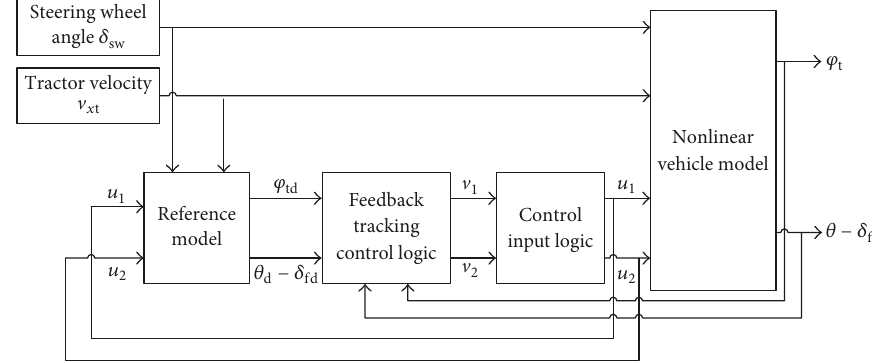
Figure 8: Structure of feedback tracking